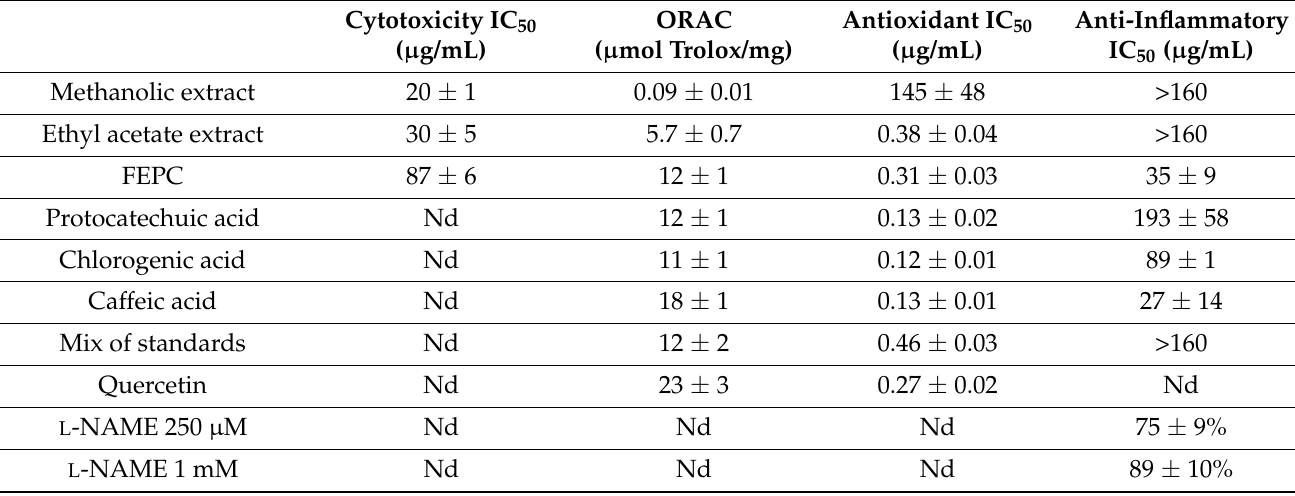
Table 4. Cytotoxic, antioxidant (WS-1 cells) and anti-inflammatory (RAW 264.7 macrophages) activities of FEPC and phenolic